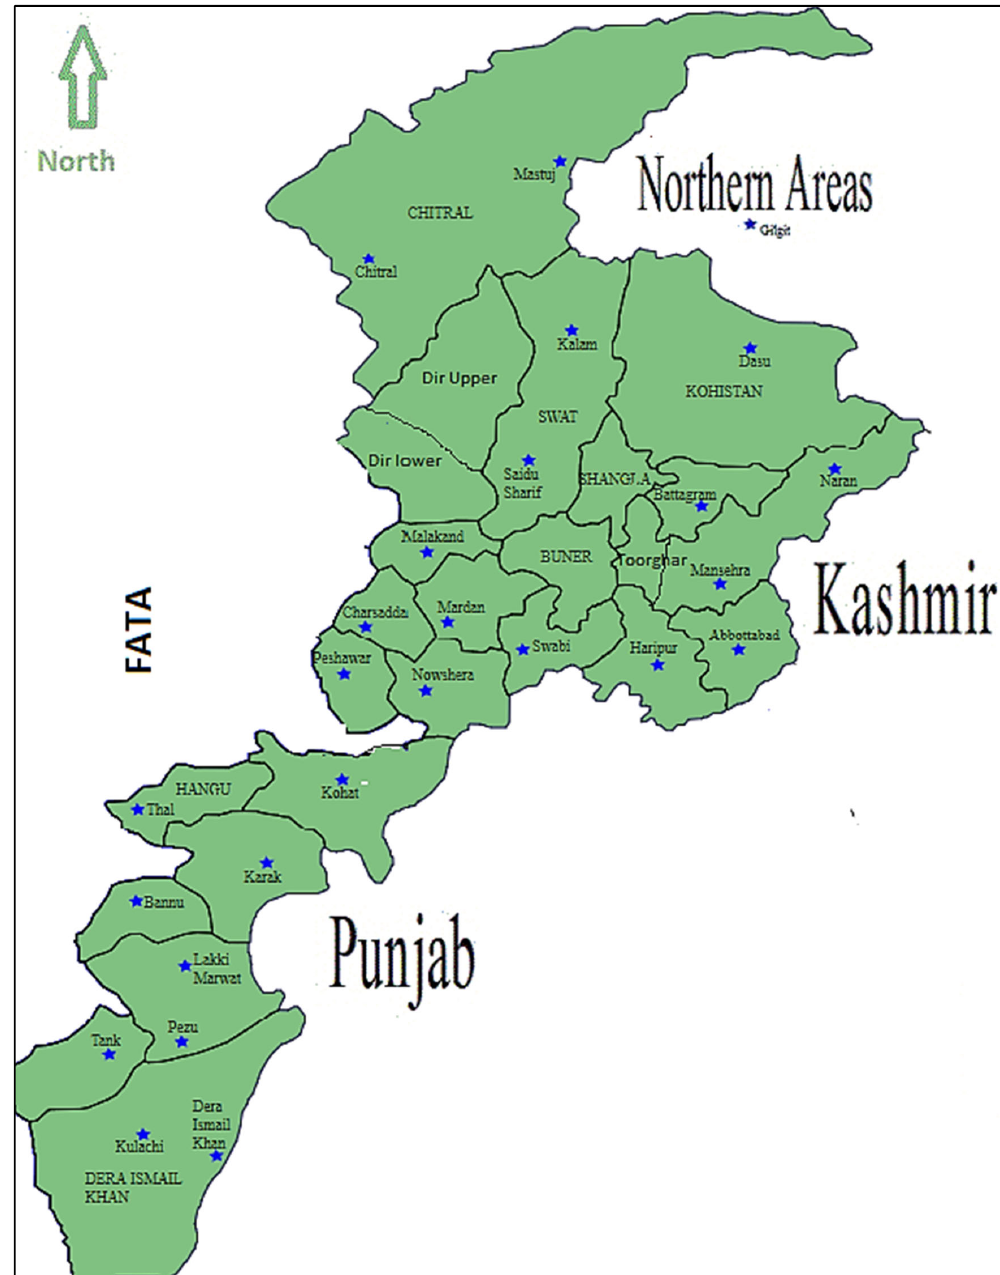
Figure 1. Map of Khyber Pakhtunkhwa province.